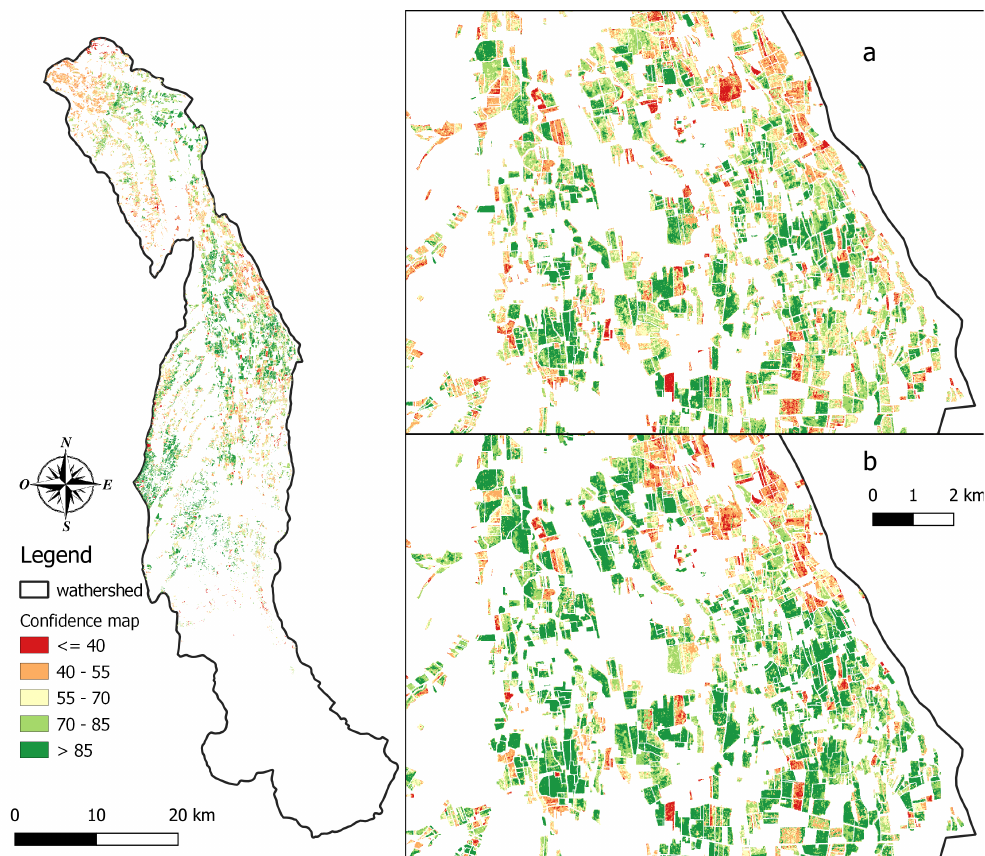
Figure 8. Confidence map for 2017: ( a ) scenario 3 and ( b ) scenario 4.